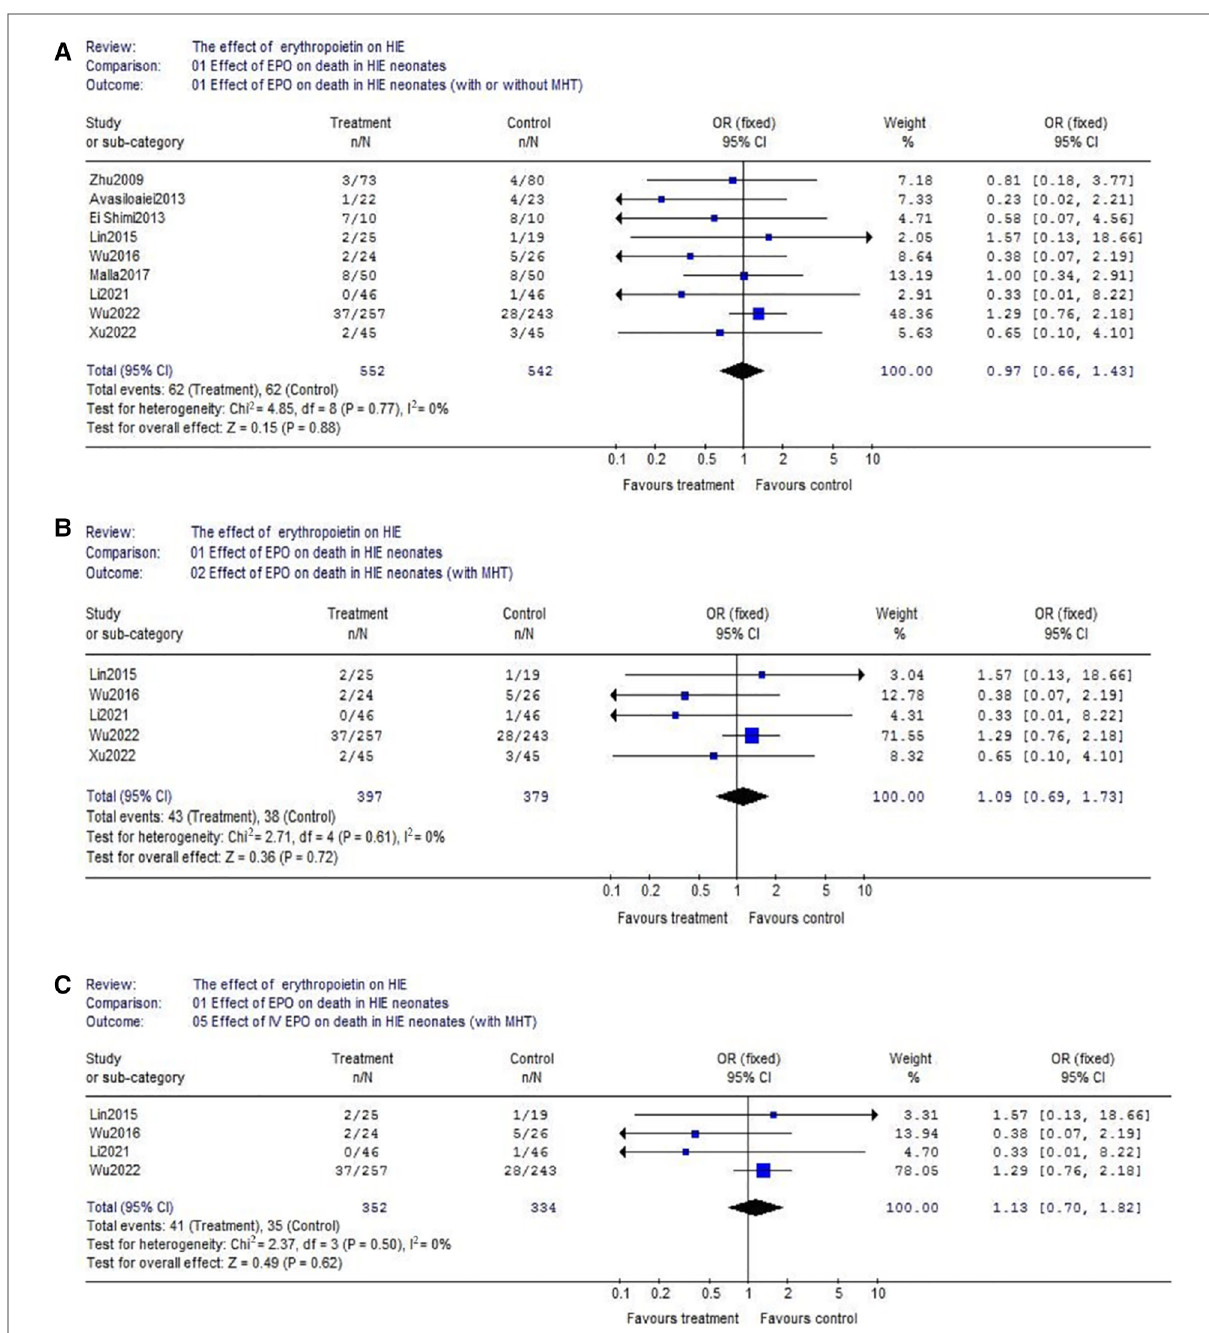
FIGURE 3 The comparison of effectiveness of EPO treatment on death. ( A ) Effect of EPO on detah in HIE neonates (with or without MHT); ( B ) Effect of EPO on detah in HIE neonates (with MHT); ( C ) Effect of IV EPO on detah in HIE neonates (with